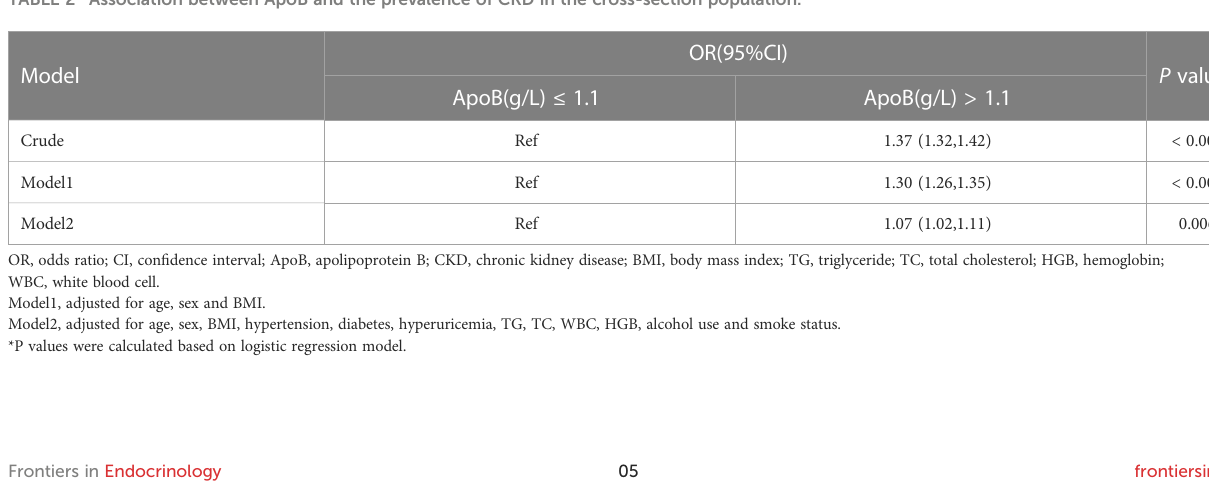
of CKD were analyzed in individuals with or without hypertension,